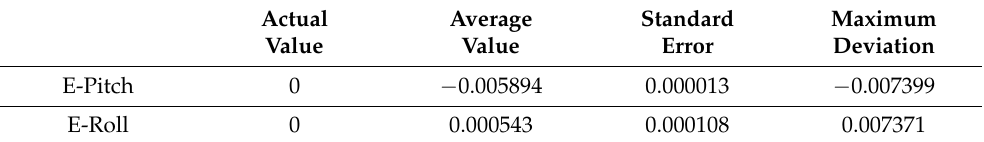
Table 2. The data of the terrain estimation.